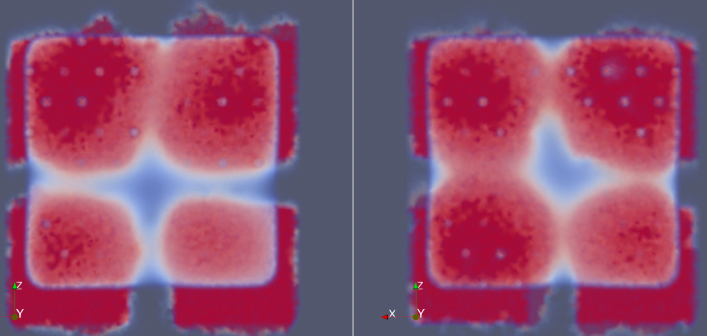
Figure 15. Comparison of oxygen concentration viewed from the top for the designs with one outlet ( left ), cf. Figure 9, and with two outlets ( right ), cf. Figure 12. The same concentration scale was used for both pictures. High oxygen concentration is shown in red, and low in white and blue. We see larger regions of high oxygen concentration in the figure on the right, corresponding to the design with two outlets. The purple dots are the outlines of the ultrafiltrate channels.